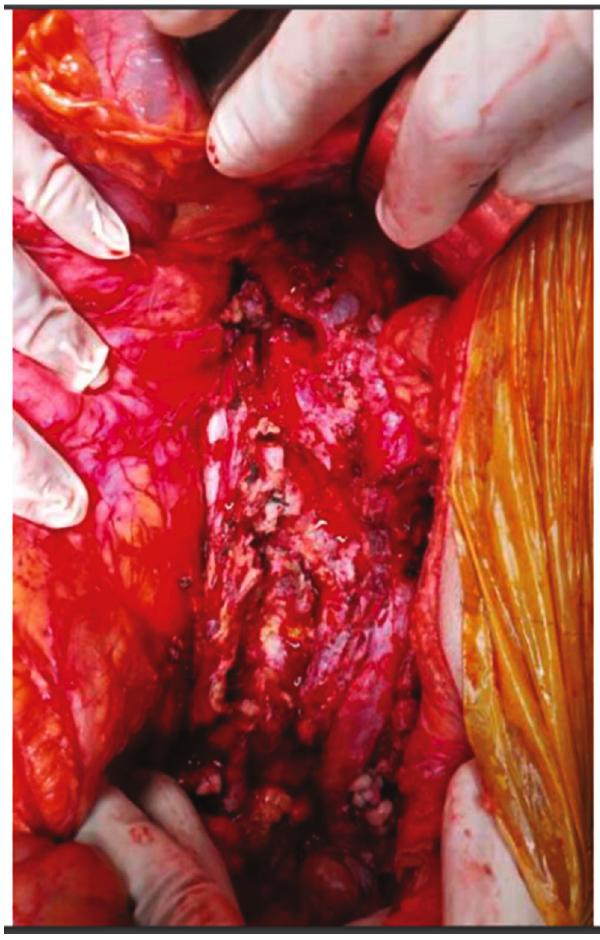
Figure 4: Most parts of the aneurysm sac were